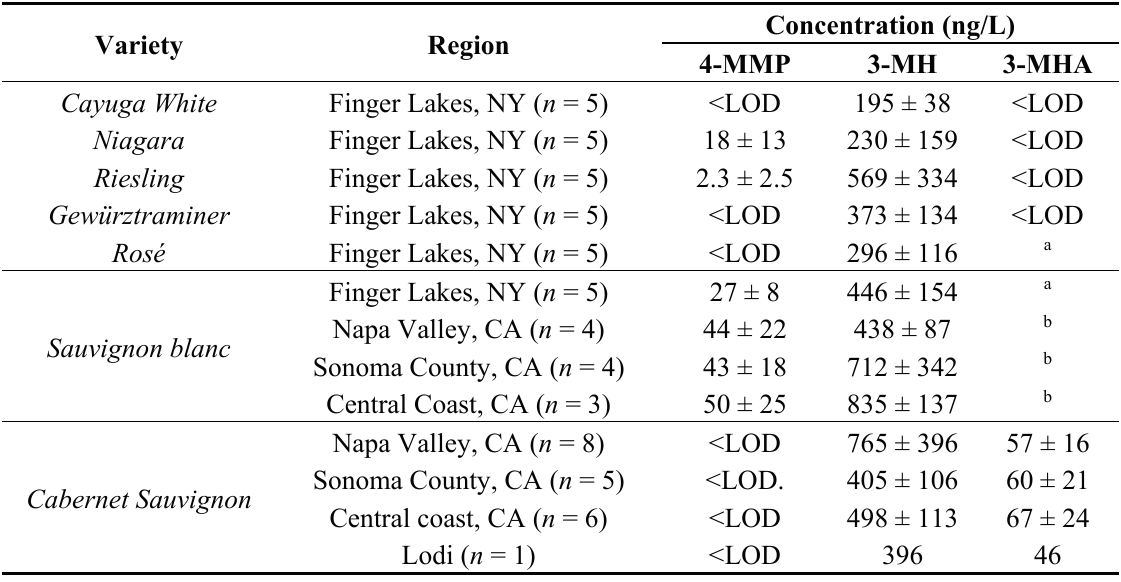
Table 3. Concentrations of volatile polyfunctional thiols in California and NY